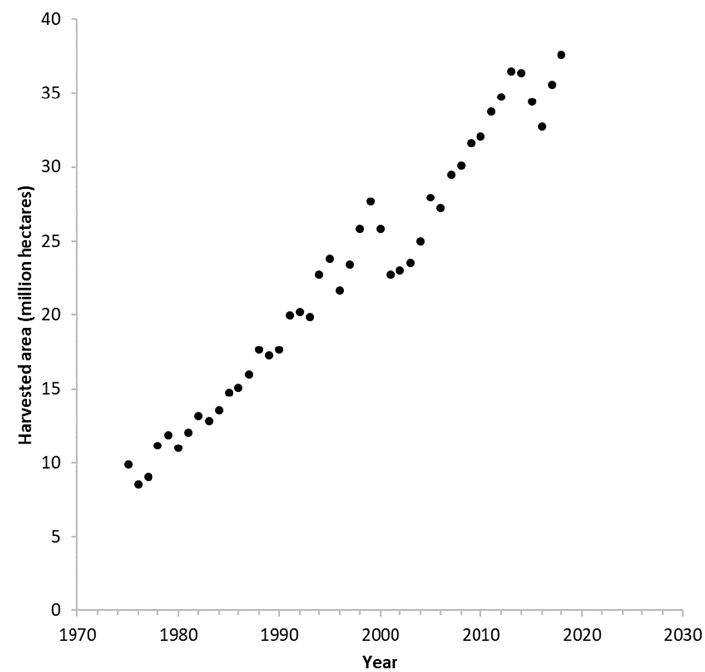
Figure 2. Global rapeseed ( Brassica napus L.) harvested hectares have increased annually since the introduction of the first low-erucic acid, low-glucosinolate canola cultivar ‘Tower’ in 1974 (data source: FAOSTAT, Food and Agriculture Organization of the United Nations, accessed on 1 September 2021).